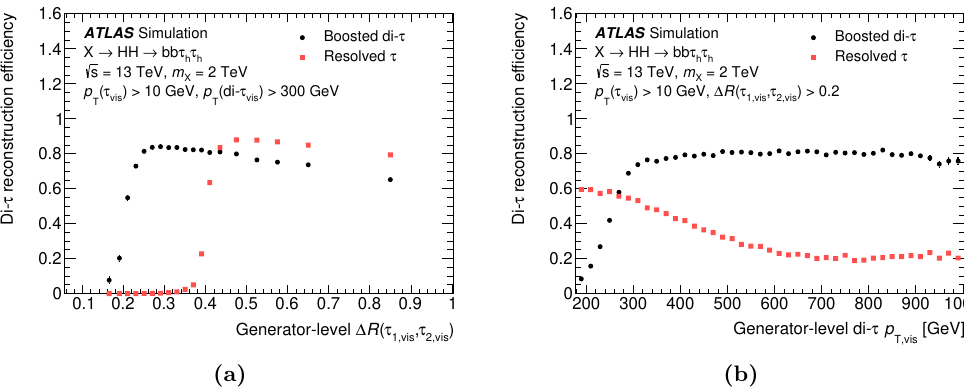
Figure 2. Efficiency to reconstruct a di- τ system with (squares) resolved τ had-vis objects and (circles) a boosted di- τ object versus (a) the distance ∆ R ( τ 1 , vis , τ 2 , vis ) between the visible products of the two hadronically decaying τ -leptons and (b) the p T of the di- τ system, both at generator level. The reconstruction efficiency is computed in simulated X → HH → b ¯ bτ + τ − events, where the resonance mass is set to 2 TeV and both τ -leptons decay hadronically (similar patterns are observed for other masses though). The vertical error bars only account for statistical